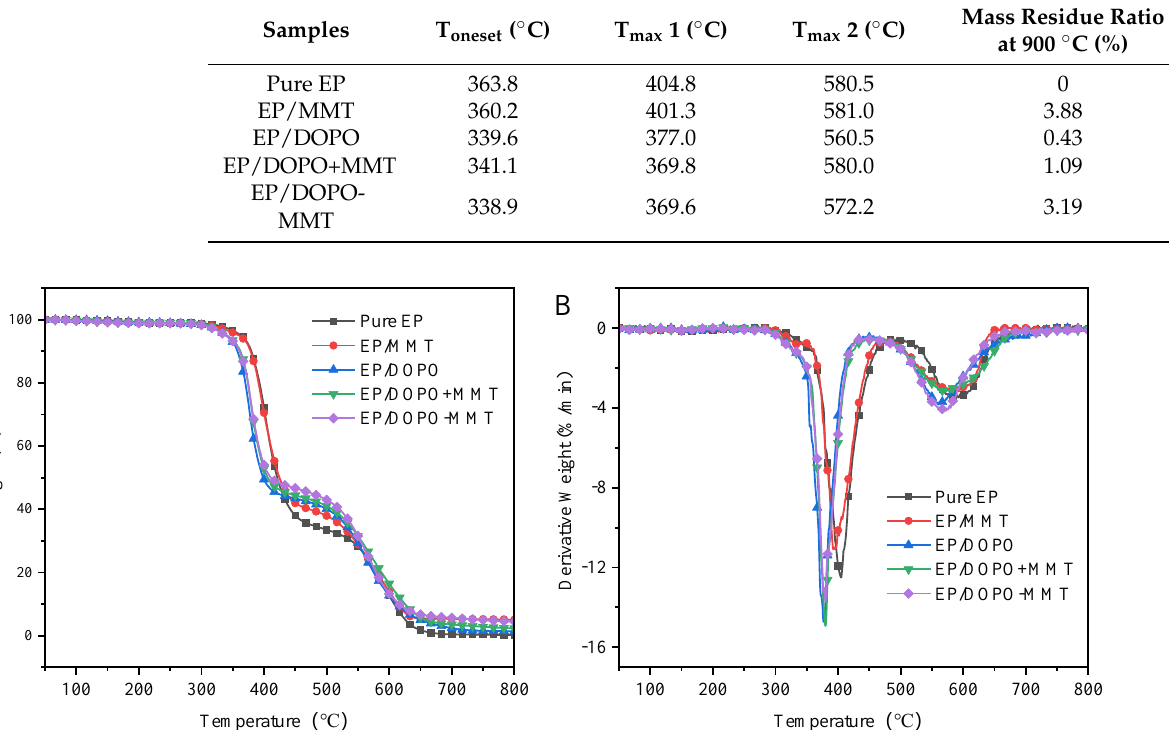
Figure 6. TG ( A ) and DTG ( B ) curves of EPs in air.